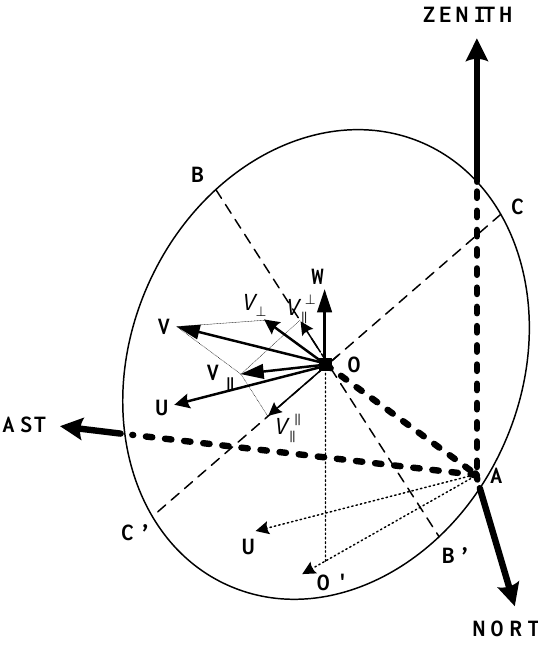
Fig. 10. Geometric relations between the wind vectors w , U , V , || 0 is the line through point O V ⊥ , V || , V ⊥ || , and V || , in which CC −→ BE as shown in Fig. 9 and BB 0 is the one normal to CC 0 parallel to on the oblique